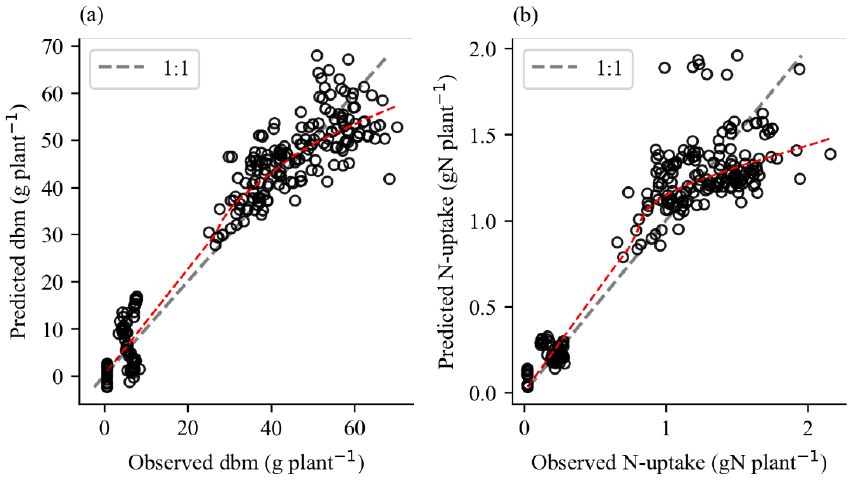
Figure 6. Scatter plots of predicted versus observed values for ( a ) leek DBM using the Lasso model and ( b ) leek N-uptake using the SLR model based on the median RWDRVI. The red dotted line shows the lowess smoother for the predictions.